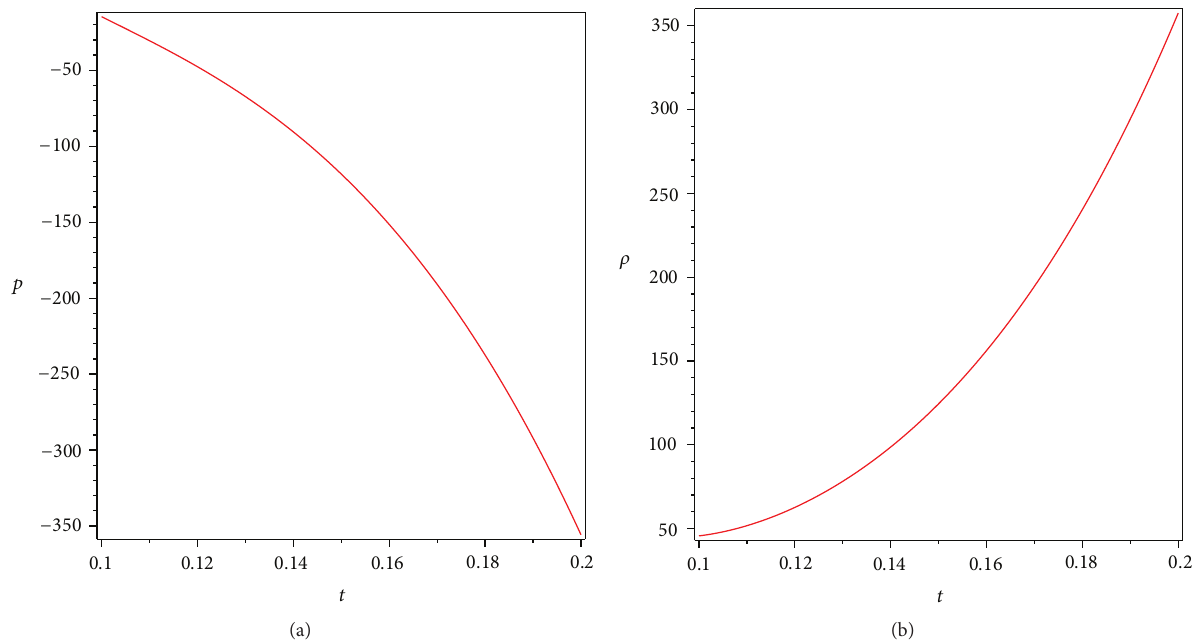
Figure 7: Variation of pressure (a) and energy density (b) with respect to time for a minimal coupling model (where 𝜁 = −2 and 𝑛 = 3 ).